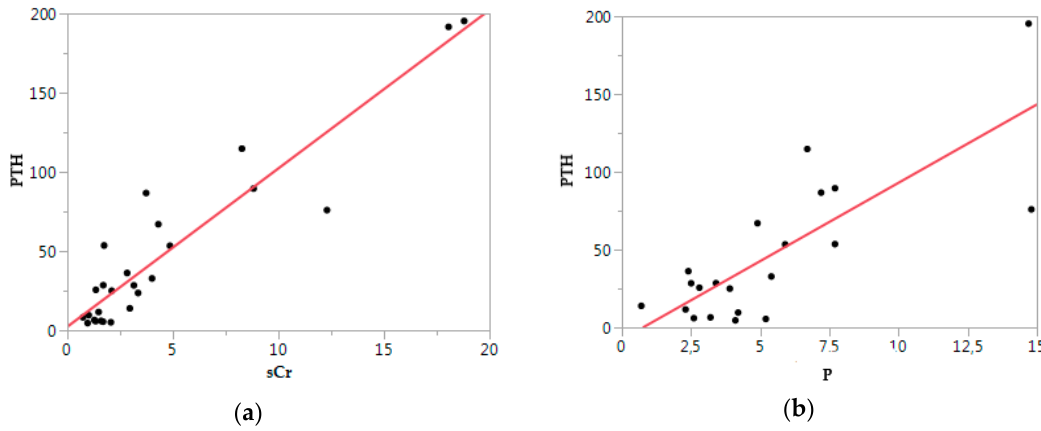
Figure 5. Parathyroid hormone (PTH) vs. biochemical parameters: ( a ) PTH vs. serum creatinine (sCr); ( b ) PTH vs. Phosphorus (P). Each point indicates a case. The red line is a tendency line. ( p = 0.0168), 0 vs. 3–4 ( p = 0.0022), 1–2 vs. 3–4 ( p =